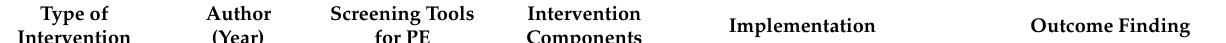
Table 2. Intervention components and delivery methods used for the intervention